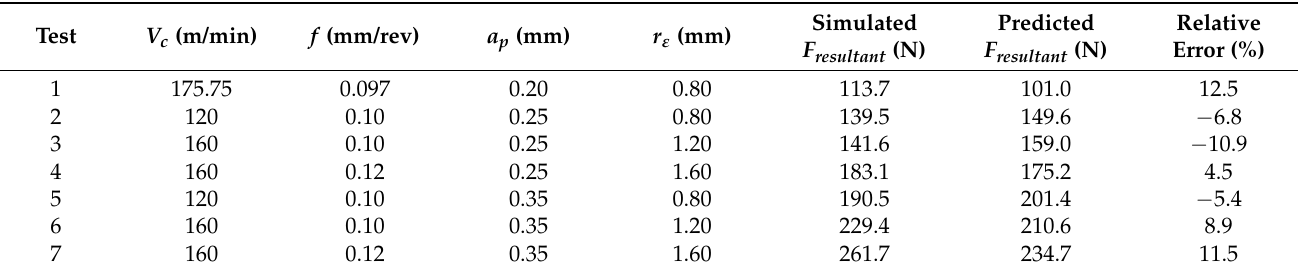
Table 8. Confirmation of statistical model for F resultant